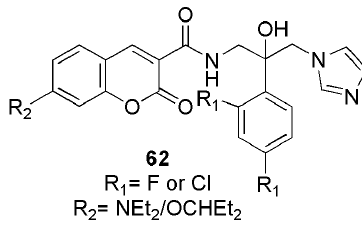
Figure 24. Coumarin derivatives conjugated to an imidazole-containing moiety.